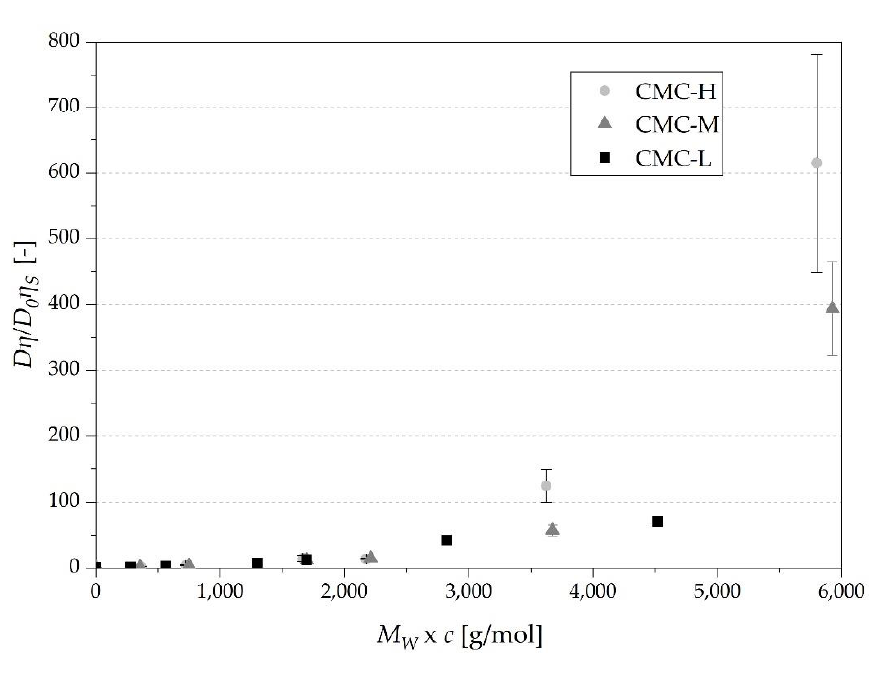
Figure 6. Deviation from Stokes-Einstein equation (Equation (1)) of the three different types of CMC. The calculated M W × c * for CMC-L, CMC-M and CMC-H were 130,000, 169,850 and 166,750 g/mol, respectively.